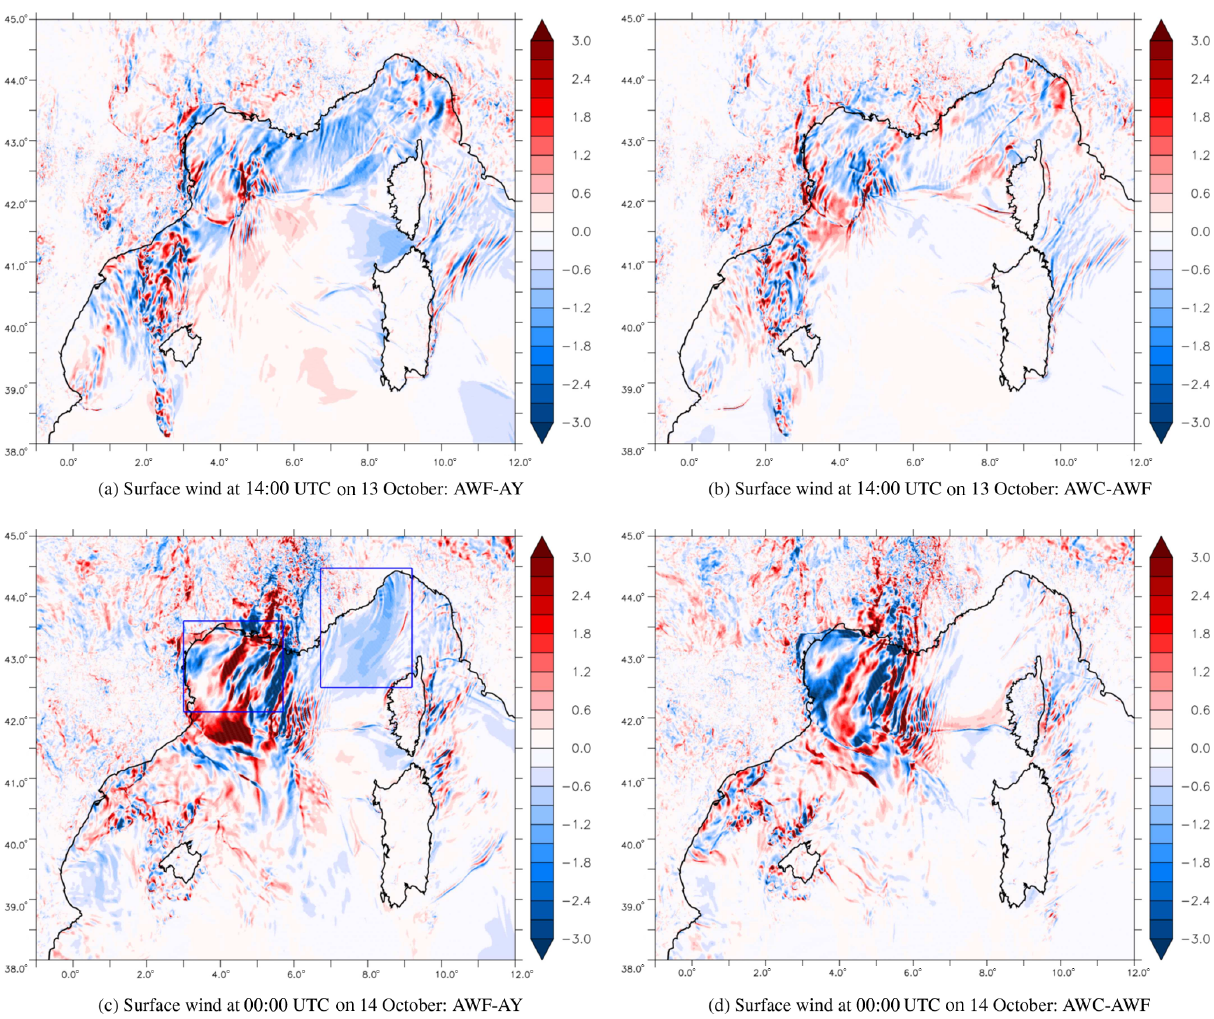
Figure 10. Surface wind (ms − 1 ) differences at 14:00UTC on 13 October (a, b) and at 00:00UTC on 14 October (c, d) between AWF–AY (a, c) and AWC–AWF (b, d)